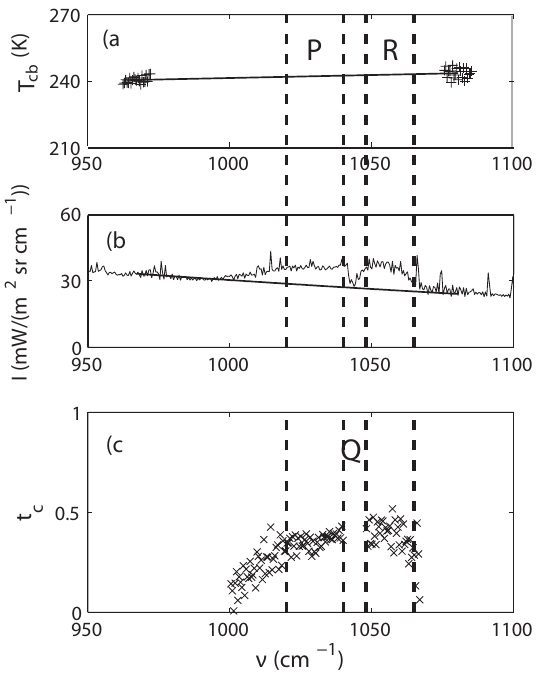
Fig. 8. The steps used to determine cloud transmittance of ozone downwelling emission in a 1038–1042cm − 1 micro-window. (Top): The brightness temperature T cb at cloud base is calculated on both sides of the ozone emission band, at 970–990cm − 1 and 1070– 1100cm − 1 ). Then, the cloud brightness temperature T cb within the P and R branches of the ozone band is obtained using lin- ear interpolation. (Middle): The background radiance I bkg from non-ozone sources is calculated from the estimated cloud bright- ness temperatures. (Bottom): The transmissivity t in the P and R branches of the ozone band is calculated from the measured downwelling radiance I sky (corrected for precipitation contribu- tions) from t = (cid:0) I sky − I bkg (cid:1) /I clear , where I clear is the clear sky downwelling radiance estimated from ozone, temperature and mois- ture profiles. Transmissivity values within the central Q branch between 1040cm − 1 and 1048cm − 1 are estimated by interpolat- ing between the two regions delimited by dashed lines. Values of t ozone are derived from a subset of transmissivity values within a 1038–1042cm − 1 micro-window where water vapour absorption is small. The data shown is from measurements at ARM NSA-AAO on 15 July